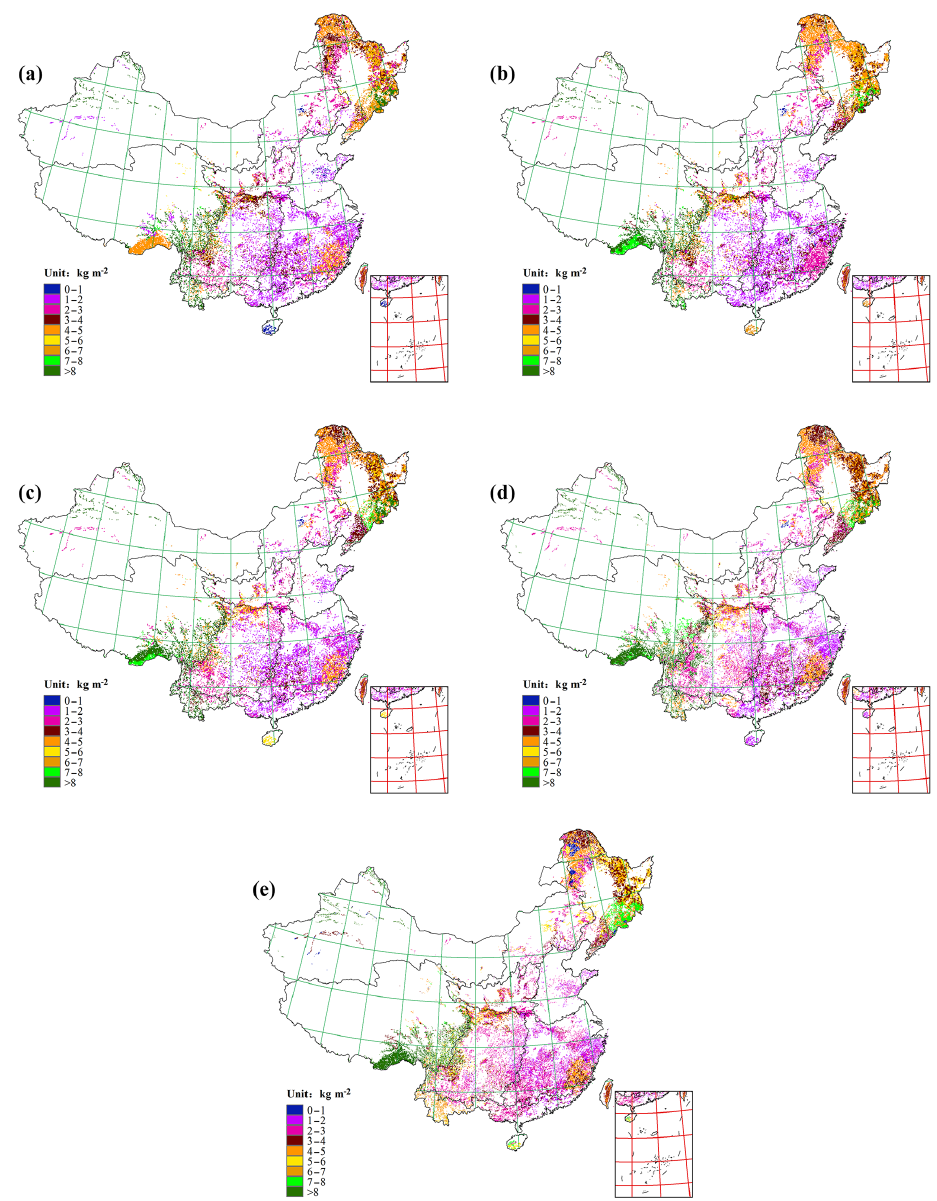
Figure 4. The spatial distribution of forest BCDs in China estimated during the five periods using HASM-S: (a) 1984–1988 (P1), (b)